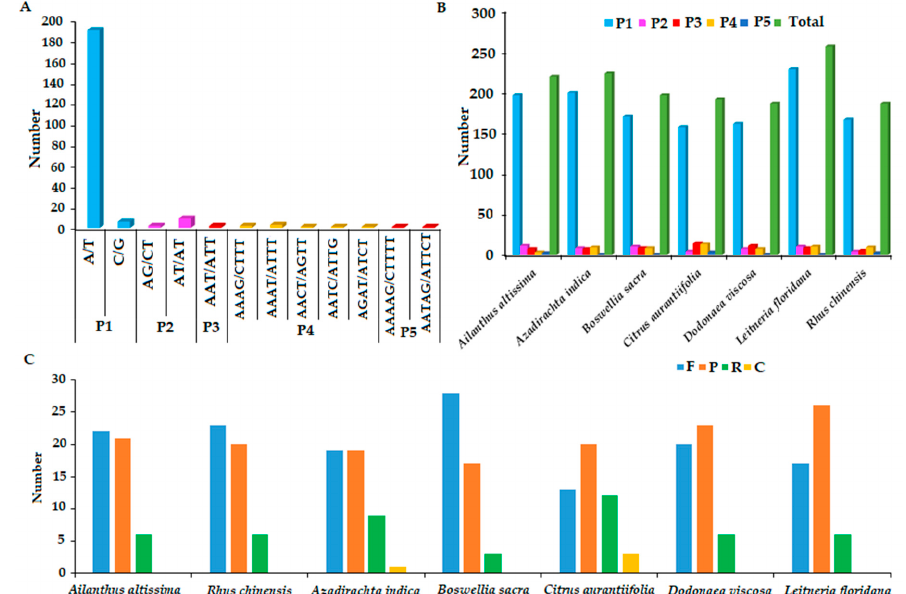
Figure 5. Simple sequence repeat (SSRs) type, distribution and presence in A. altissima and other representative species from Sapindales. ( A ) Number of detected SSR motifs in different repeat types in A. altissima Chloroplast genome. ( B ) Number of identified repeat sequences in seven chloroplast genomes. ( C ) Number of different SSR types in seven representative species. F, indicate (forward), P (palindromic), R (reverse), and C (complement), while P1, P2, P3, P4, P5 indicates Mono-, di-, tri-, tetra-, and penta-nucleotides respectively. F: forward; P: palindromic, R: reverse; C: complement.